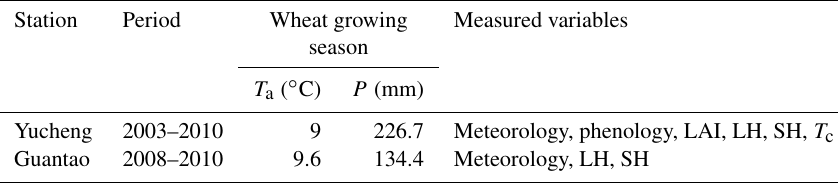
Table 2. General information about model verification data. Station Period Wheat growing Measured variables